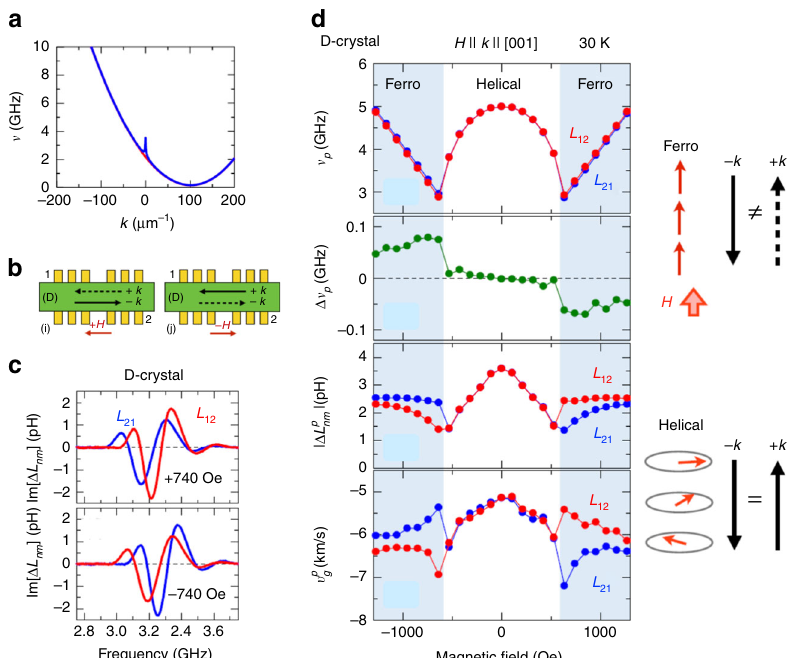
Fig. 2 Spin wave spectroscopy on the nonreciprocal magnon transport in a chiral magnet. a Asymmetric spin wave dispersions for the collinear ferromagnetic state in a chiral magnet MnSi according to Eq. (3); a sharp spike around k~0 is due to the dipolar interaction. b The experimental setup to detect the nonreciprocity for the magnon transport between the coplanar microwave guides (ports 1 and 2). c Imaginary part spectra of the mutual inductance Δ L 12 ( Δ L 21 ), representing the transport of the magnons from 1 to 2 (from 2 to 1) for magnetic fi elds applied parallel ( + H ) or antiparallel ( – H ) to the propagation direction; the result for the enantiomer D-body crystal. Another enantiomer L-body crystal shows the opposite behaviors for the exchange between Δ L 12 and Δ L 21 . d Magnetic fi eld dependence of spin wave nonreciprocity between Δ L 12 and Δ L 21 (i.e., + k and − k ), measured for the D-body crystal of Cu 2 OSeO 3 with the H // k // [001] con fi guration at 30 K. Here, ν p indicates the magnetic resonance frequency giving the peak value of | Δ Lnm |, and Δ ν p the difference between ± k , respectively. | Δ L p nm | and v p g indicate the corresponding peak value and the group velocity at the frequency ν p . The right panel shows the schematic illustration of collinear ferromagnetic state and helical spin state, respectively. The nonreciprocal spin wave propagation between ± k is discerned only in the former spin state. Reprinted fi gure with permission from ref 29 . Copyright (2016) by the American Physical